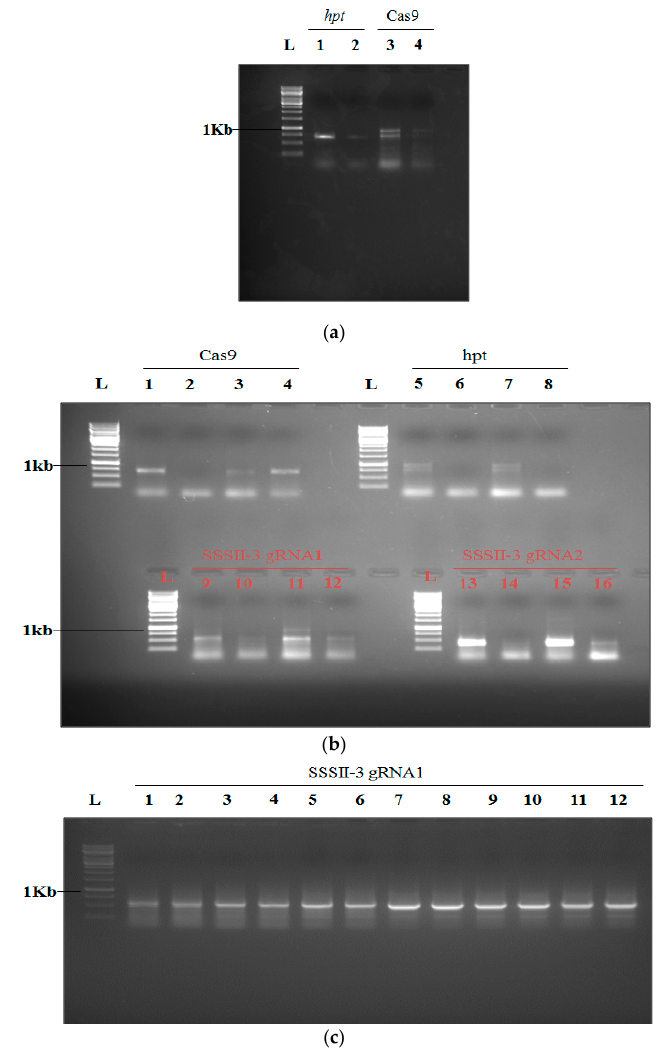
Figure 6. The confirmation of transgenic plant lines in the laboratory by PCR using isolated DNA from mutant plants of PB1509 and control plants. L band is 1 kb DNA ladder ( a ). The confirmation of the Cas9 primers by PCR is shown in bands 1 and 2 as well as bands 3 and 4, which were con- firmed with hygromycin( hpt ) resistance gene primers. ( b ) 1 to 4 bands of Cas9 were confirmed Cas9 primers of SSSII-3 gene, 5 to 8 bands of the Hygromycin resistance gene were confirmed by related primers, 9 to 12 bands of SSSII-3 gRNA1 were PCR-confirmed with SSSII-3 target 1 sequence pri- mers, and bands 13 to 16 of SSSII-3 gRNA2 were confirmed with SSSII-3 target 2 sequence primers. ( c )The duplicate bands 1 to 6 at Tm 57 °C and bands 7 to 12 at Tm 58 °C of SSSII-3 target 1 sequence primers were confirmed.